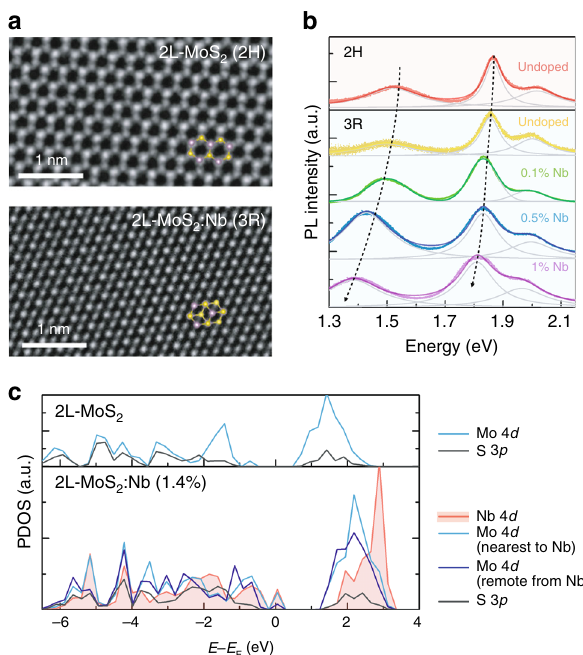
Fig. 2 Beyond the 2H – 3R structural transition: Restructuring of valence bands in bilayer Nb-doped MoS 2 . a High-resolution transmission electron microscopy (HRTEM) images of typical bilayer (2L) MoS 2 and Nb-doped MoS 2 fl akes. The insets show a modeled top view of 2H and 3R MoS 2 bilayers with violet and yellow spheres corresponding to Mo and S atoms, respectively, and are superimposed onto the HRTEM images. Here the existence of Nb dopants is not presented due to its substitutionality and indistinguishability from Mo in HRTEM (Z Nb = 41 and Z Mo = 42). Scale bars, 1 nm. b Room temperature photoluminescence (PL) spectra of 2L MoS 2 including both 2H and 3R structures, and MoS 2 :Nb with three representative doping concentrations. The arrow line shows the evolution of indirect bandgap to guide the eye. c Calculated partial density of states (PDOS) of 2L undoped and Nb-doped MoS 2 (3R-stacked) projected onto the selected atoms, Mo, Nb and S. For the bilayer MoS 2 :Nb, one of the 72 Mo atoms is substituted with a Nb dopant atom (corresponding to 1.4% doping) to match the experimental doping level. Also, two representative Mo atoms, the nearest to and remote away from Nb dopants, are shown here to resolve their distinct contributions to the valence band